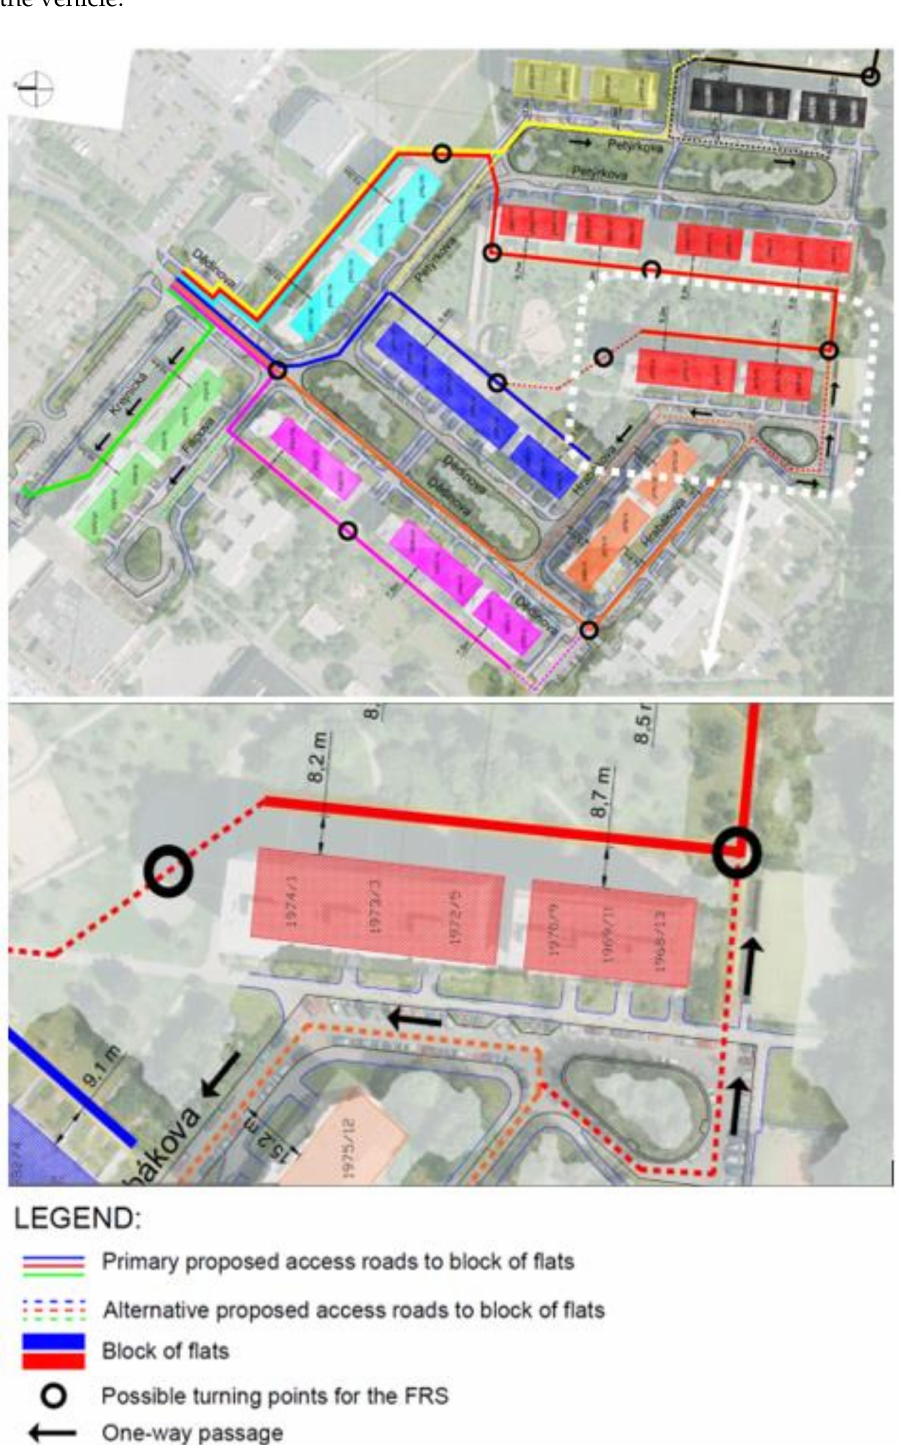
Figure 12. Schematic representation of the serviceability proposal for the evaluated area together with details of the selected